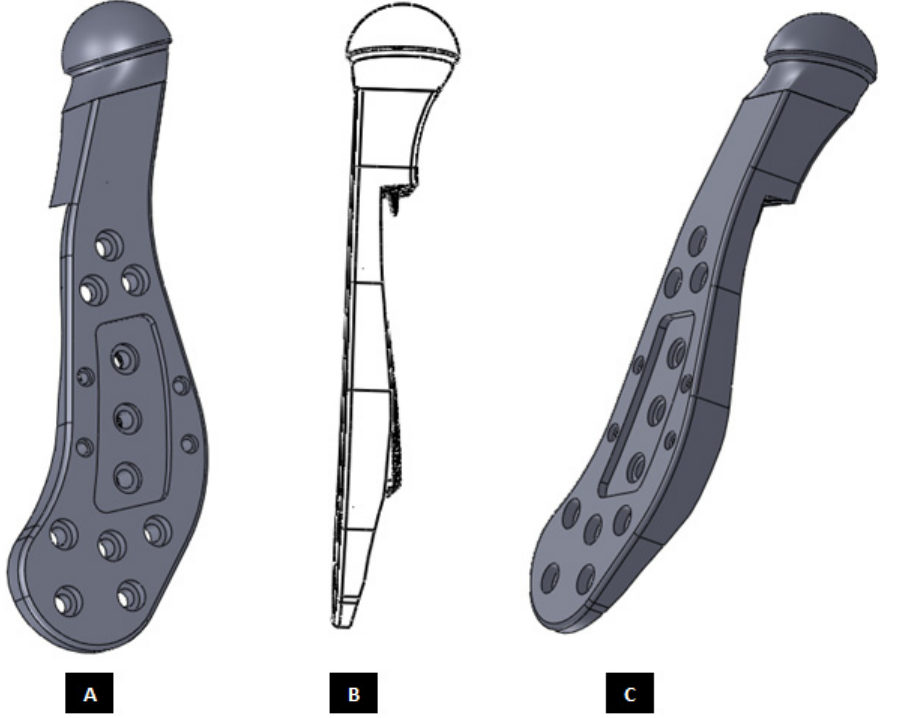
Figure 12. Modification and refinement of custom-designed condylar/ramus component shown in Figures 9 and 11. ( A , C ) Show pre-drilled screw holes and a grove in the lateral surface of implant. As shown in ( C ), lateral surface of the device is flat and medial surface is shaped to match the host bone geometry. ( B ) Shows a perforated notch each protruding from the medial surface of the ramus and inferior surface of the implant